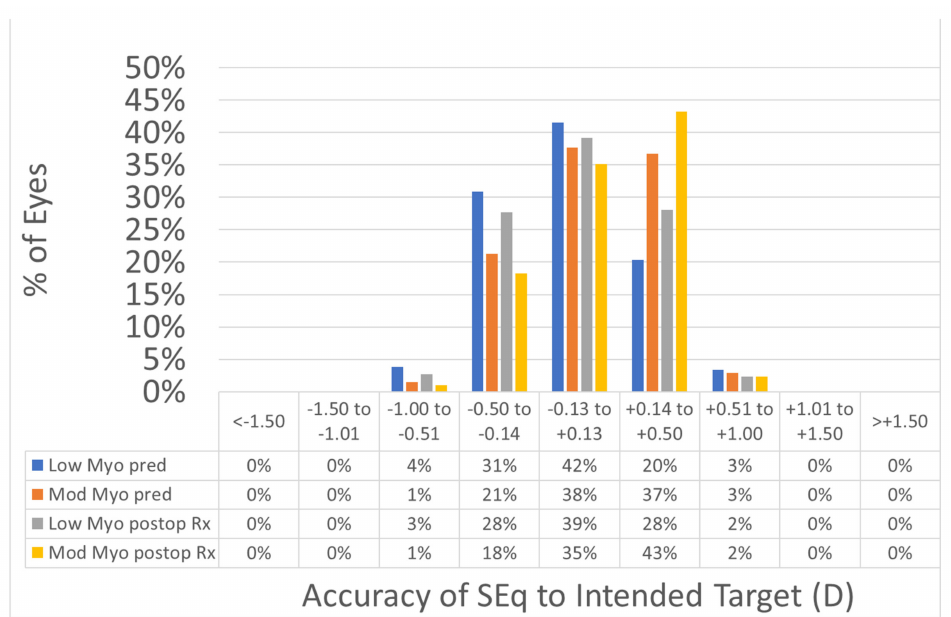
Figure 5. Accuracy expressed in SEQ deviation from the intended versus achieved. The predictability of the treatments was not different between the two myopic ranges. The deviation from the intended target was − 0.04 ± 0.33 D in the low myopia group, and +0.07 ± 0.32 D in the moderate myopia group ( p < 0.0001); the postop SEQ was 0.00 ± 0.33 D in the low myopia group, and +0.10 ± 0.31 D in the moderate myopia group ( p < 0.0001). In 94% of the eyes in the low myopia group and 96% of the eyes in the moderate myopia group, the SEQ was within 0.5D from the intended